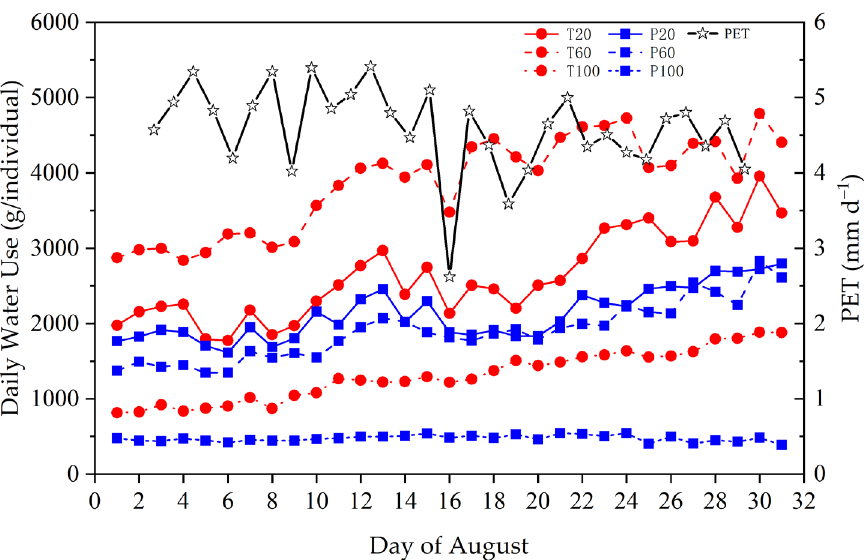
Figure 2. Daily PET (mm d − 1 ) and water use (g d − 1 ) per lysimeter with Populus euphratica and Tamarix ramosissima seedlings grown 20 cm, 60 cm, and 100 cm from the groundwater level.